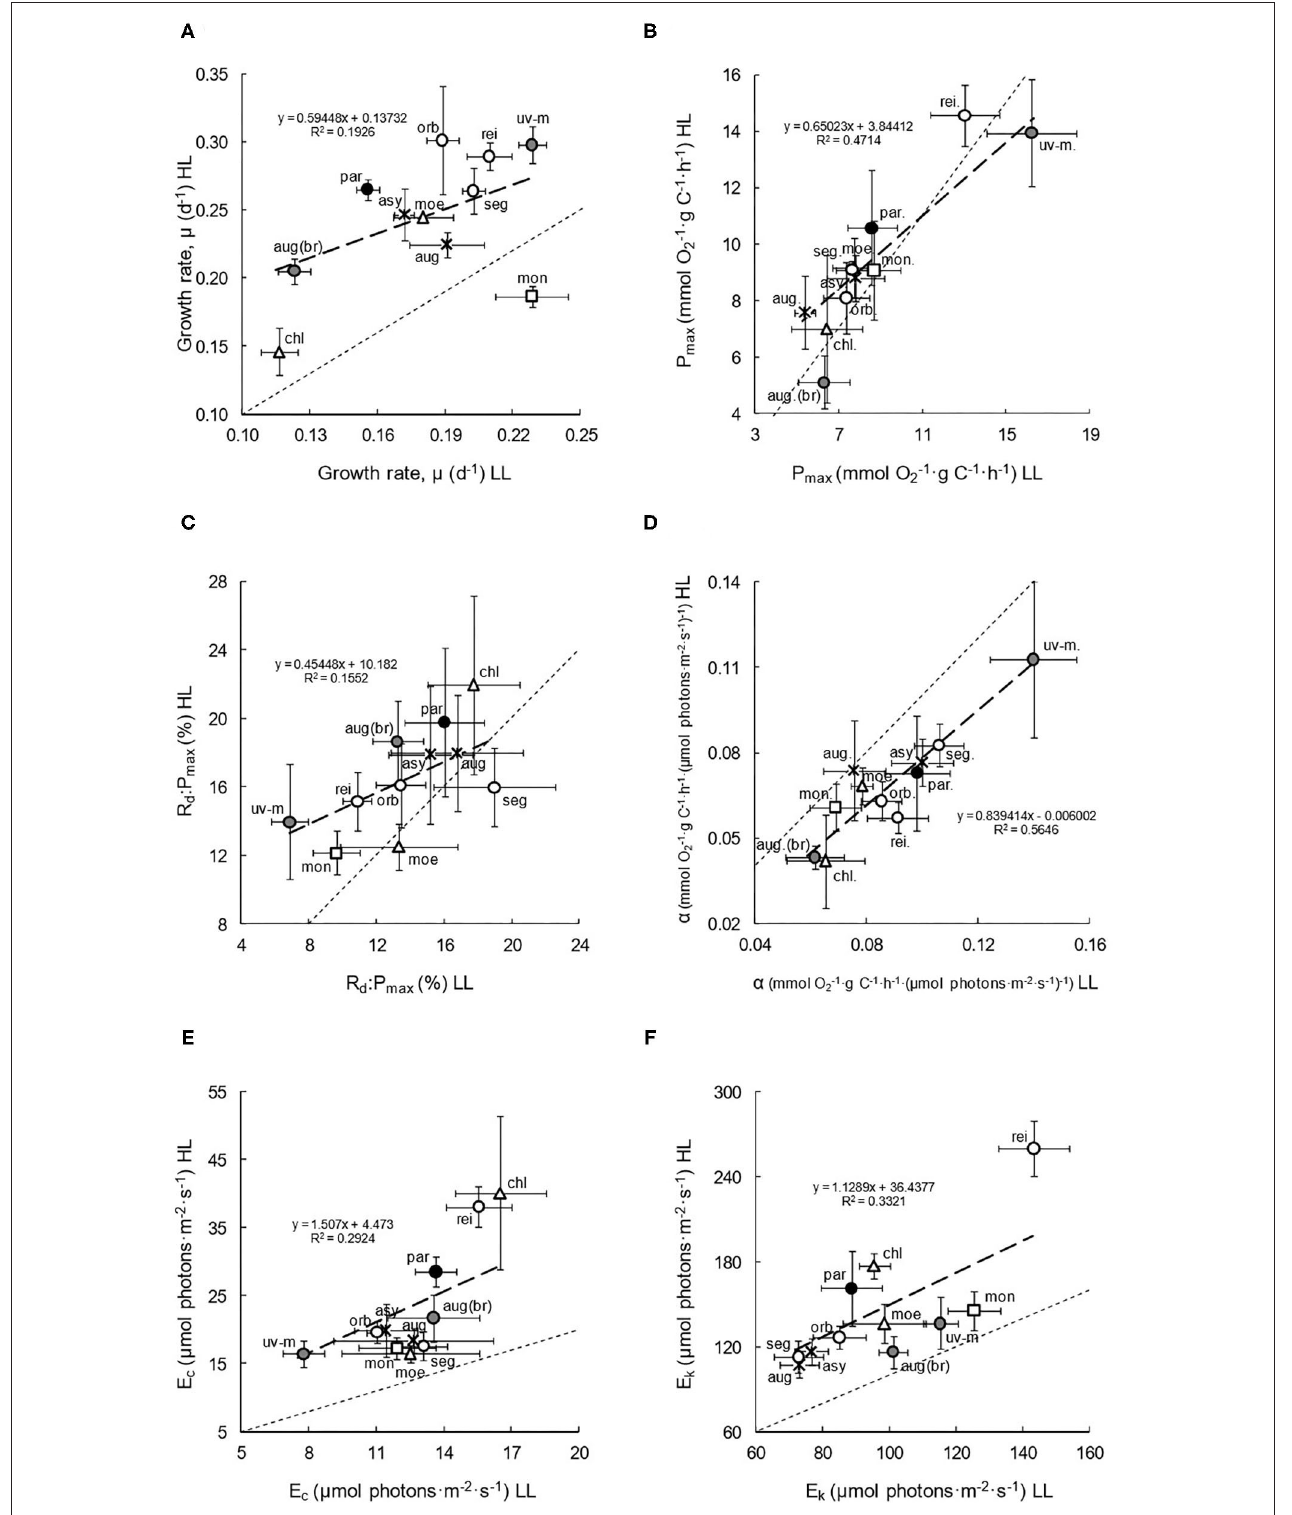
FIGURE 2 | Physiological characteristics (A–F) , of the 11 species of Chlamydomonas grown under conditions of low light (LL) and high light (HL). Mean values and standard errors are presented in each scatterplot. The thin dashed lines represent theoretical 1:1 ( x = y ) relationships between LL and HL adapted cultures,